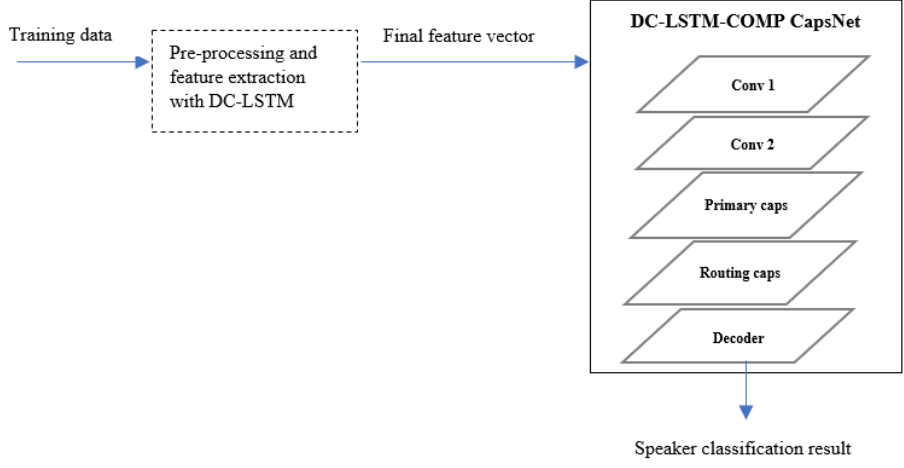
Figure 3. Block diagram of speaker verification of the proposed DC-LSTM-COMP CapsNet in the training phase.